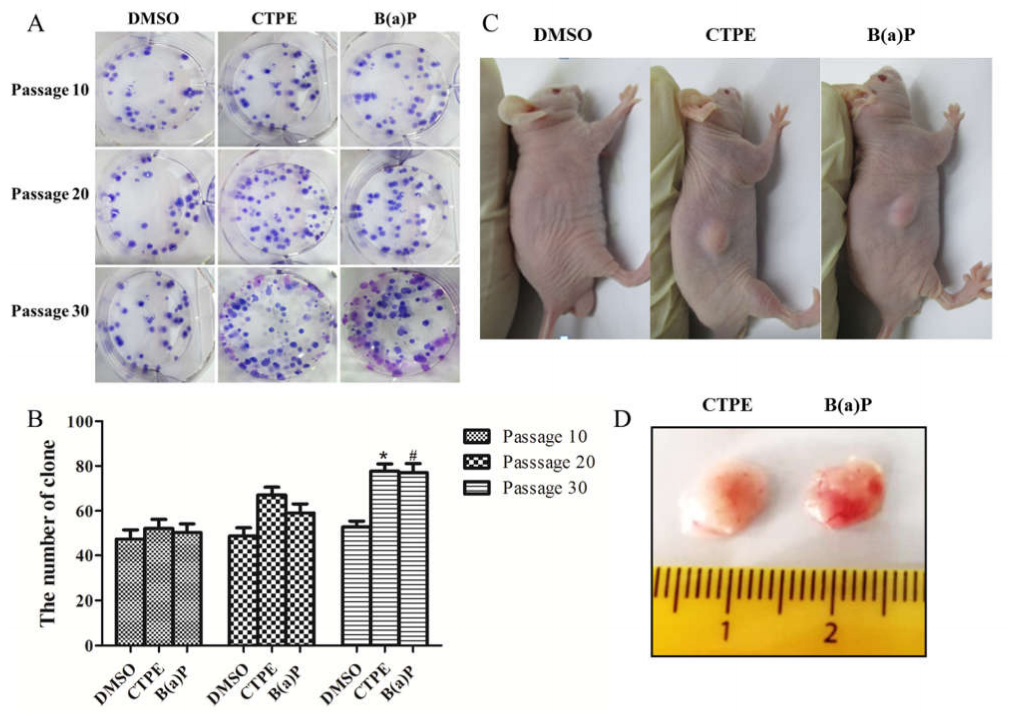
Figure 1. Clone formation in plate and tumor formation in nude mice using cells at passage 30. ( A ) Representative clones in different passages and groups. ( B ) The number of clones in different passages and groups ( n = 3, *: CTPE vs. DMSO, p < 0.05. #: B(a)P vs. DMSO, p < 0.05). ( C , D ) Tumor formations were observed in nude mice on the 38th day after injecting CTPE- or B(a)P-induced BEAS-2B cells at passage 30.